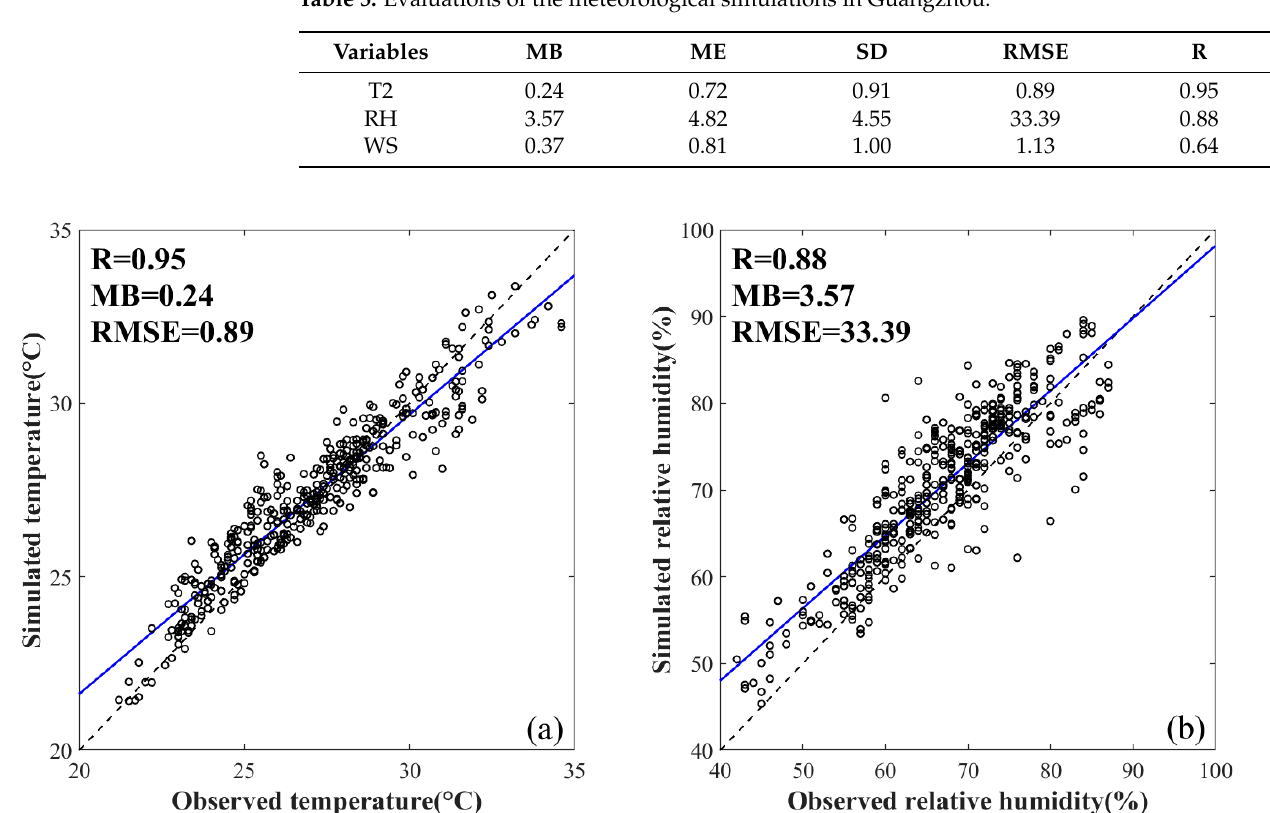
Figure 7. Scatter plots of the WRF-Chem simulated hourly data with the observed hourly data in Guangzhou. The black dashed lines were the 1:1 lines as the reference. ( a , b ) were the WRF-Chem model simulations of 2 m temperature and 2 m relative humidity, respectively. Table 5. Evaluations of the meteorological simulations in Guangzhou.